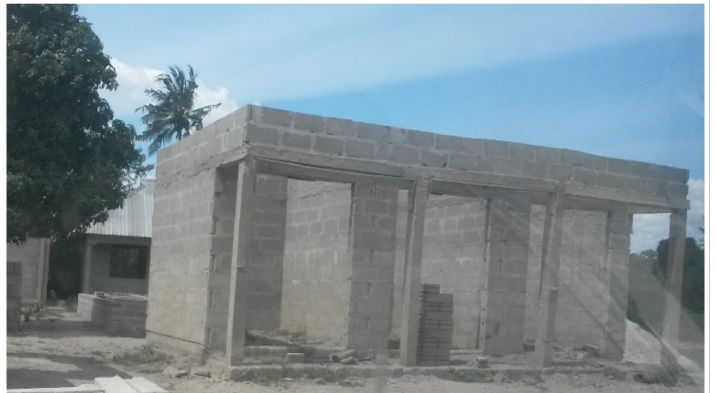
Figure 4. Unfinished cement block wall house structure, which often remain unfinished due to conflicts about land ownership (photo: Saskia Wolff 2017).